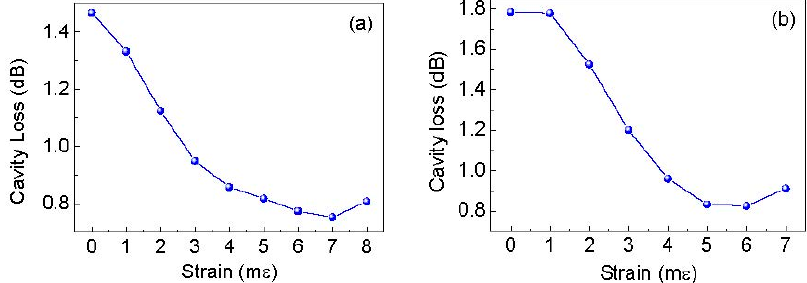
Figure 4. Cavity loss as a function of strain when the multimode fiber (MMF) is drawn into the tapered fiber. ( a ) Sensing point one, ( b ) sensing point two.